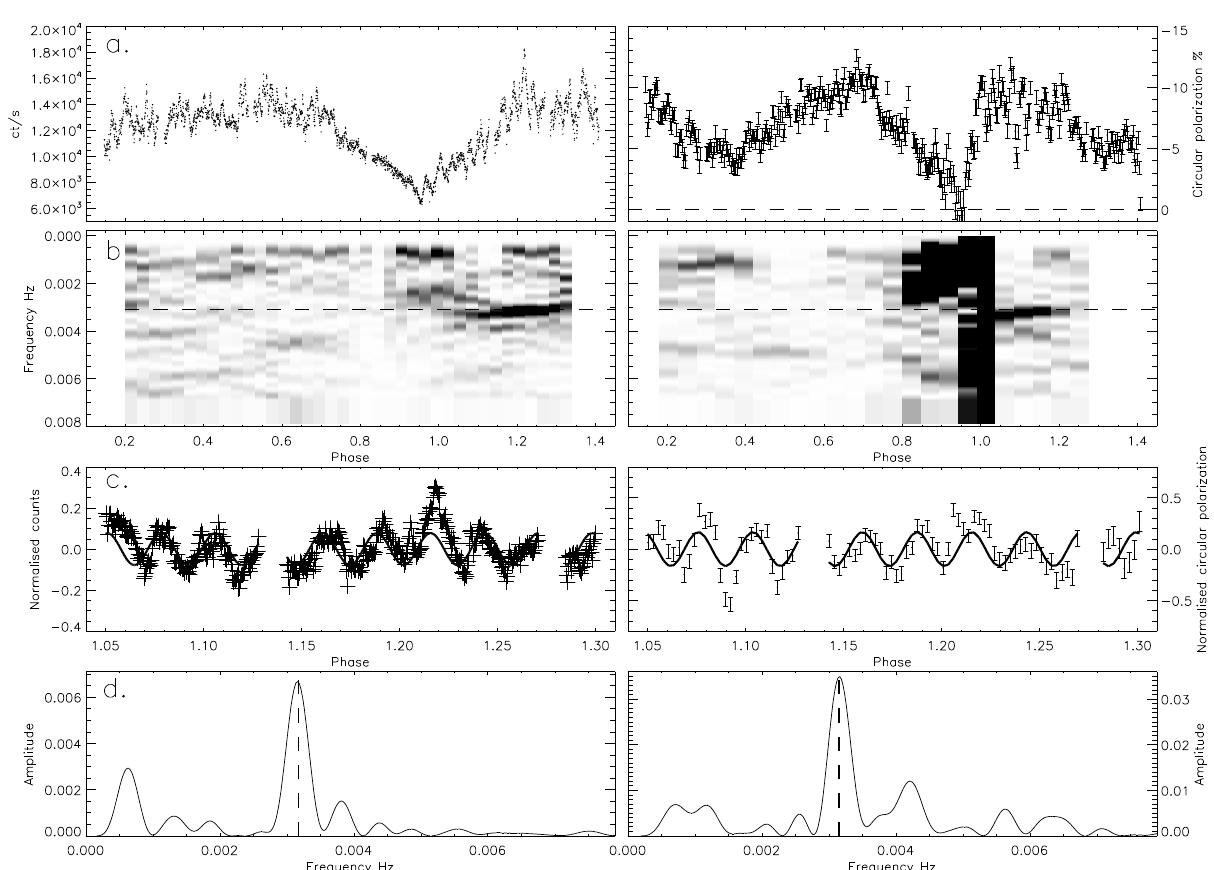
Figure 2: Left plots, a-d: The photometry, the corresponding trailed amplitude spectra, the normalised pho- tometry for the phase range 1.0-1.3 and its corresponding amplitude spectra respectively. The solid curve is the least squares fit using the frequency derived from the trailed spectra (dashed line). Right plots: as in the left plots but for the circular polarization. Figure reproduced from Potter et al.